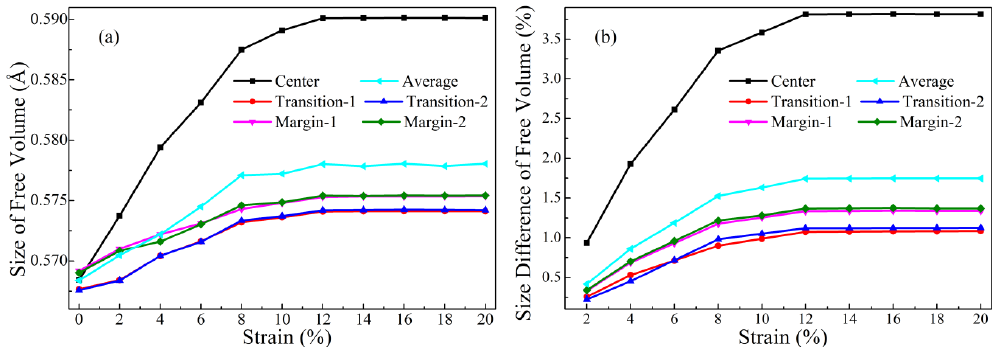
Figure 5. Relations between free volumes (large unfilled spaces whose radii are larger than 0.4 Å ) and strain in tension mode, including: ( a ) the sizes of free volumes and ( b ) the difference ratio of sizes at different strains. All the curves of the center, transitional 1, 2, marginal 1, 2 regions and their averages are plotted.